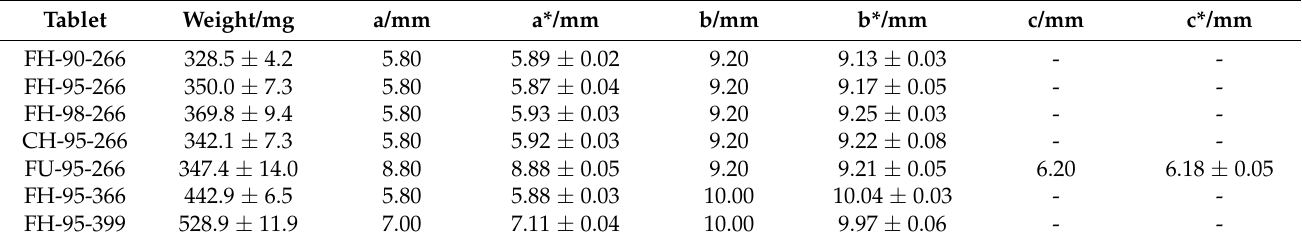
Table 2. Weight and size of the core–shell 3D-printed tablets (mean ± SD, n =